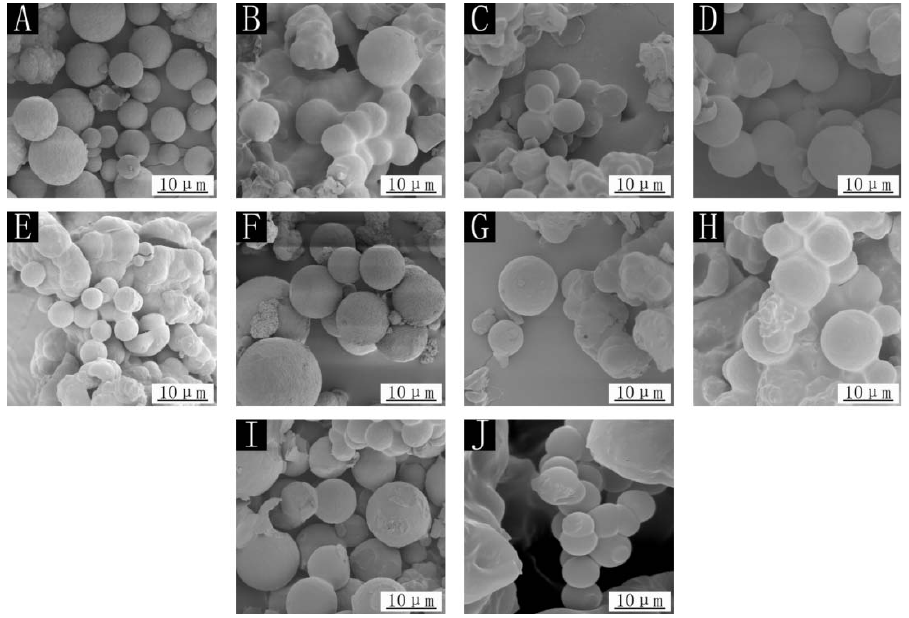
Figure 1. SEM of microcapsules: ( A ) sample 1, ( B ) sample 2, ( C ) sample 3, ( D ) sample 4, ( E ) sample 5, ( F ) sample 6, ( G ) sample 7, ( H ) sample 8, ( I ) sample 9, ( J ) sample 10.